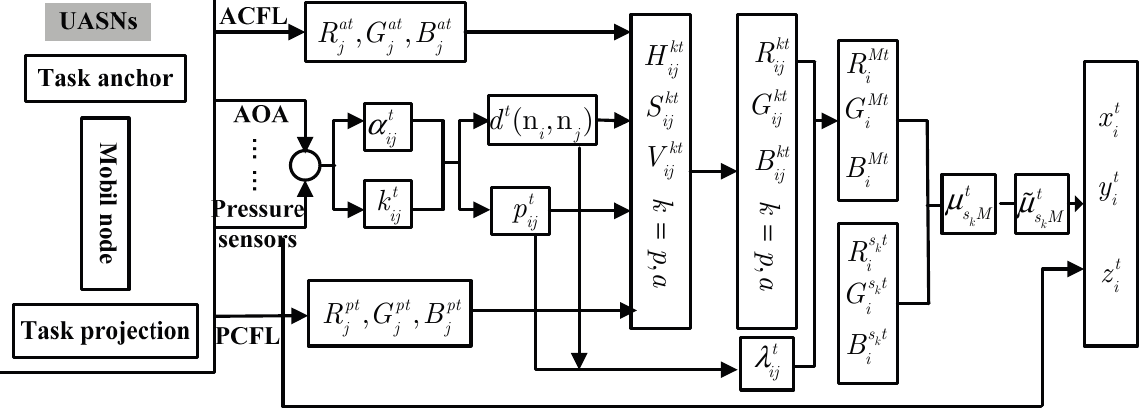
Figure 4. The architecture for PCFL and ACFL